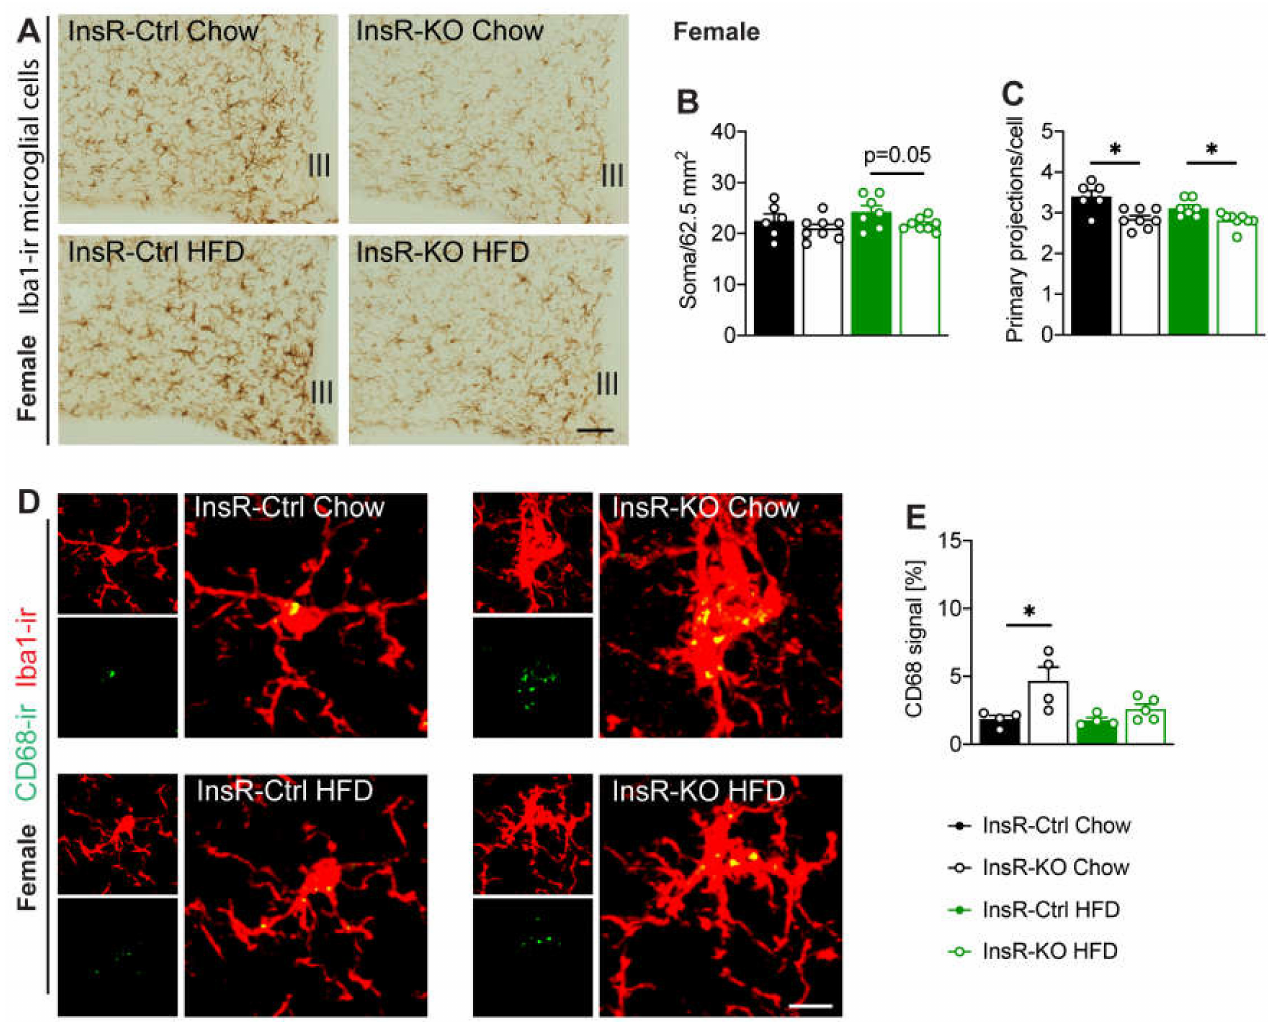
Figure 4. Lack of microglial InsR function leads to impaired microglial morphology and phagocytic capacity in the arcuate nucleus of female mice. ( A ) Iba1-ir microglia in the arcuate nucleus, Iba1-ir ( B ) soma number, and ( C ) primary projections ( n = 6–8). There was a borderline significant decrease in microglial soma number in InsR-KO females, compared to InsR-Ctrl mice, when fed an obesogenic diet. InsR-KO mice had lower primary projections compared to InsR-Ctrl mice, irrespective of diet. ( D , E ) CD68-ir co-localization with Iba1-ir microglia in the ARC ( n = 4–5). InsR-KO female mice had higher CD68-ir, compared to InsR-Ctrl mice under physiological conditions. Data presented for female InsR-Ctrl and InsR-KO mice fed a Chow diet (black) or HFD (green) following 12 weeks of diet exposure. Data are presented as mean ± SEM. * p < 0.05. III—3rd ventricle. Scale bar: 100 µ m in ( A ); 10 µ m in ( D